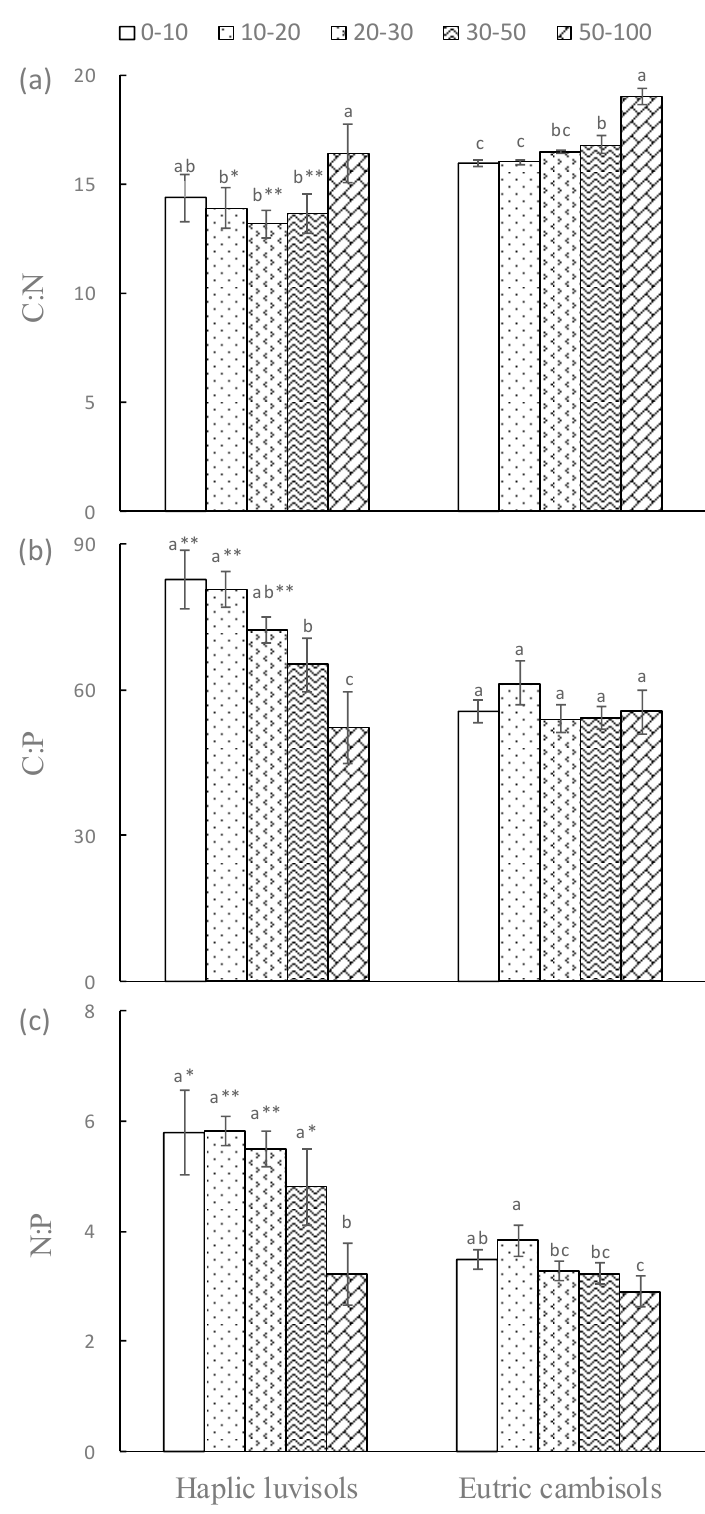
Figure 2. Changes in soil C:N:P stoichiometry in Haplic luvisols and Eutric cambisols. ( a ) C:N ratio, ( b ) C:P ratio, ( c ) N:P ratio.